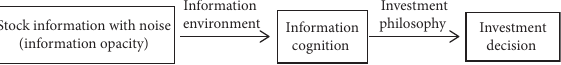
Figure 1: Information transfer process in investment decision of institutional